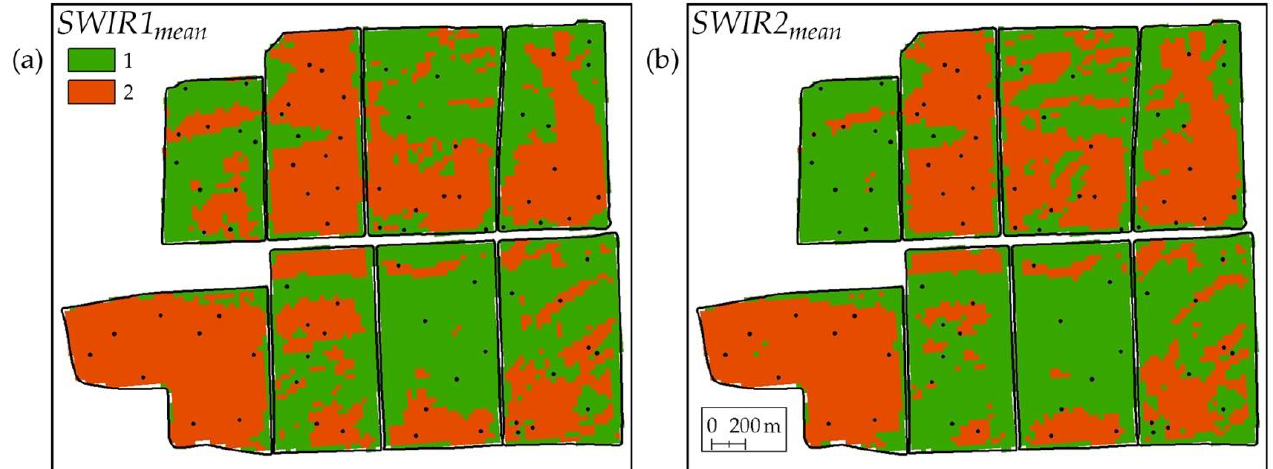
Figure 10. Degradation distribution maps constructed by direct classification of multi-temporal spectral characteristics: 1 — non-degraded soils, 2 — degraded soils.